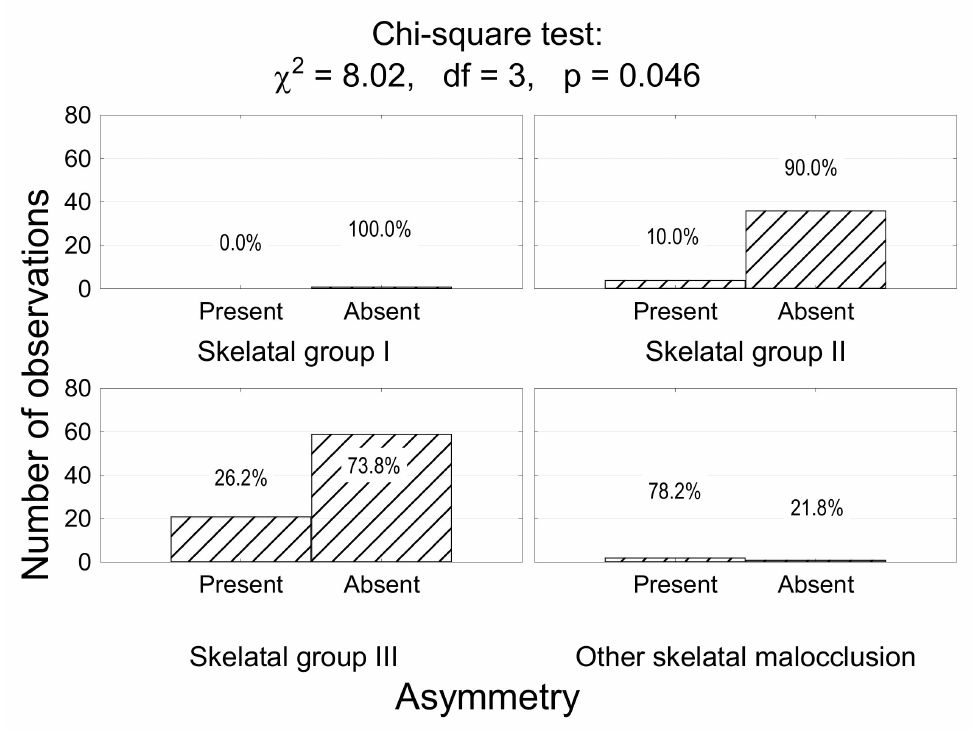
Figure 6. The number (percentage) of patients in the groups with different skeletal classes and incidences of asymmetry, and the result of the Chi-squared test.